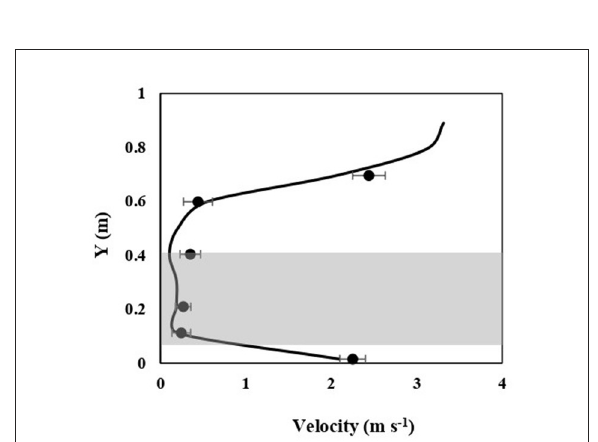
TABLE 3 Percentage of root mean square error for mass loss, velocity, and temperature profile.